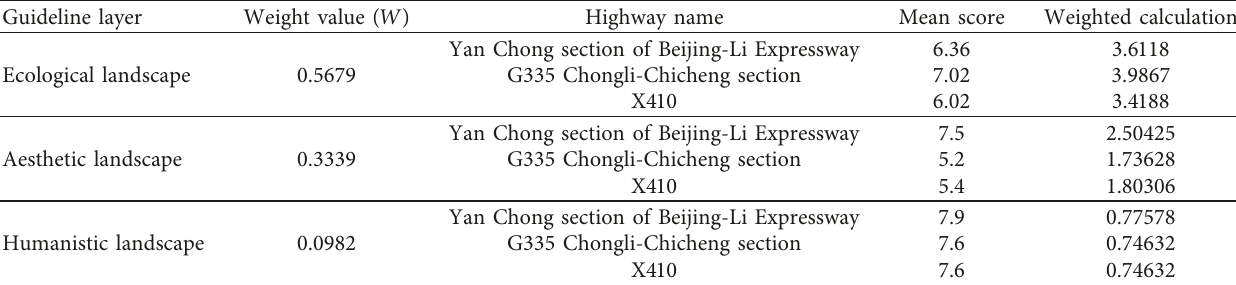
Table 10: Criterion layer weighted calculation